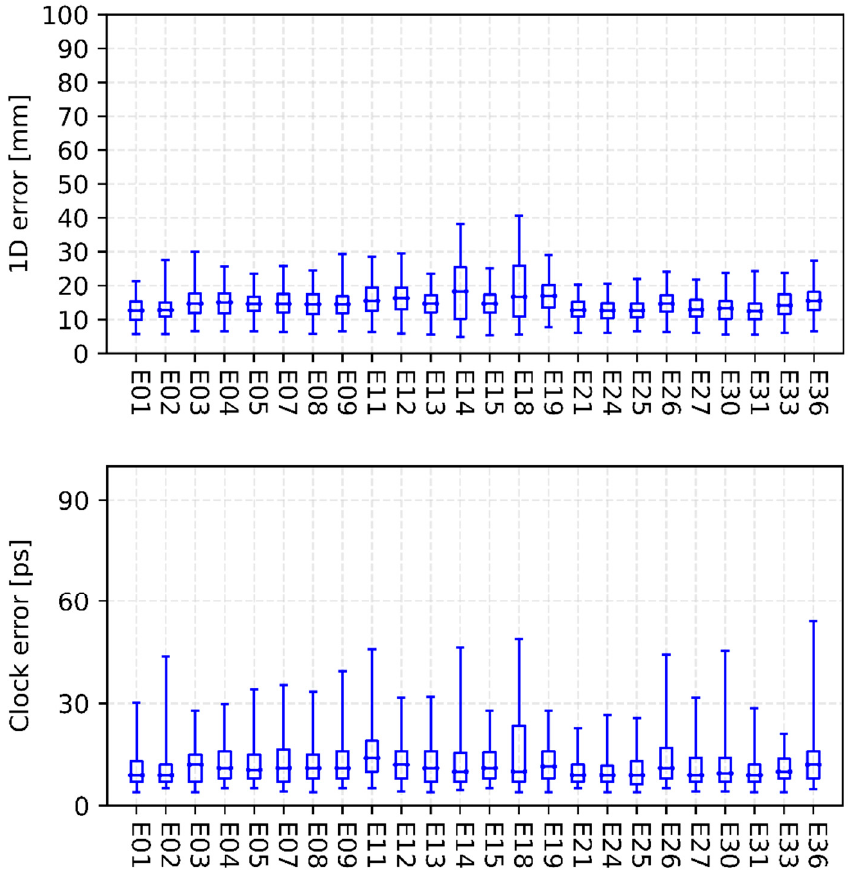
Figure 6. Internal precision of iGMAS final combined Galileo orbit ( top panel ) and clock ( bottom panel ).